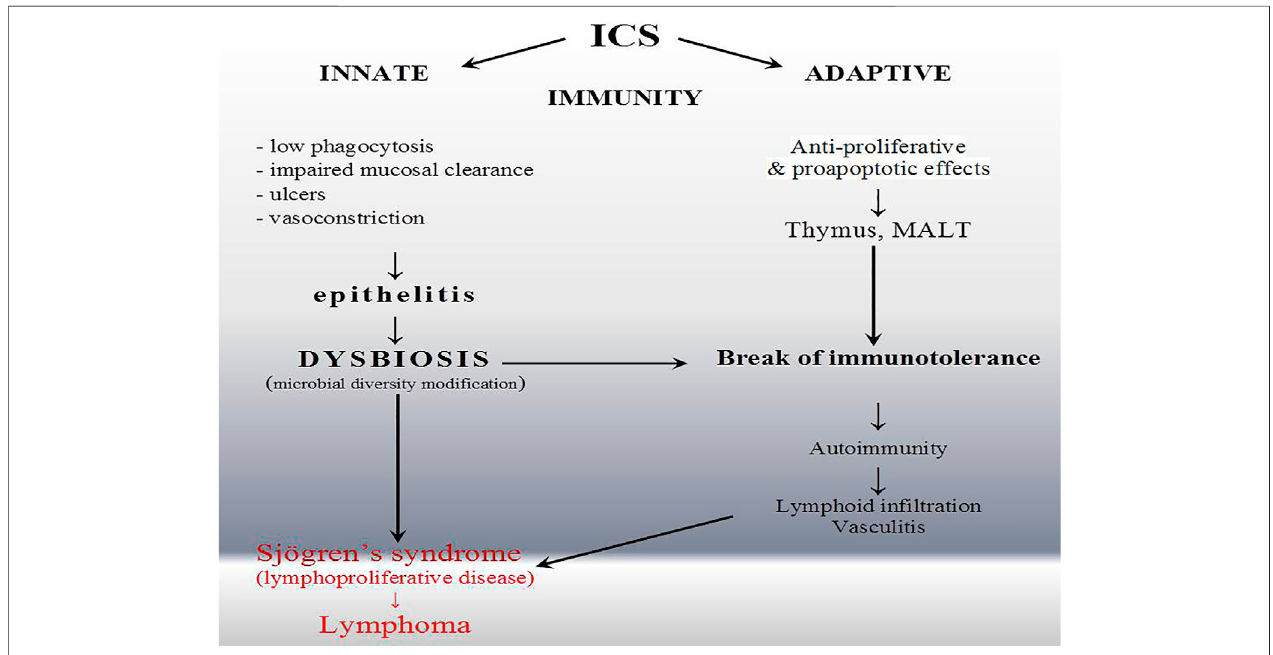
FIGURE3| In fl ammatorycomplicationofinhaledcorticoid(ICS)overuse.ThewidespectrumofimmunomodulatoryeffectsofICSandin fl uenceonepithelialbarrier promptlymphocyte selectioninthymus(Tcell)ormucosa-associatedlymphatictissue(MALT)(BandTcells)intensi fi edbynon-speci fi cperturbationand dysbiosis. ICS, unlike drugs typically associated with drug-induced lupus, have a direct in fl uence on the immune system. Nevertheless, they also induced systemic rather than organ- speci fi c autoimmunity.